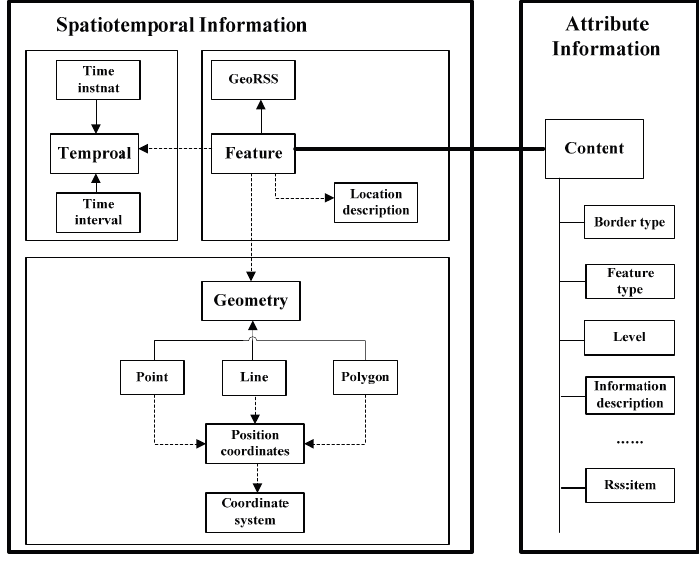
Figure 4. The structure of a spatial event based on